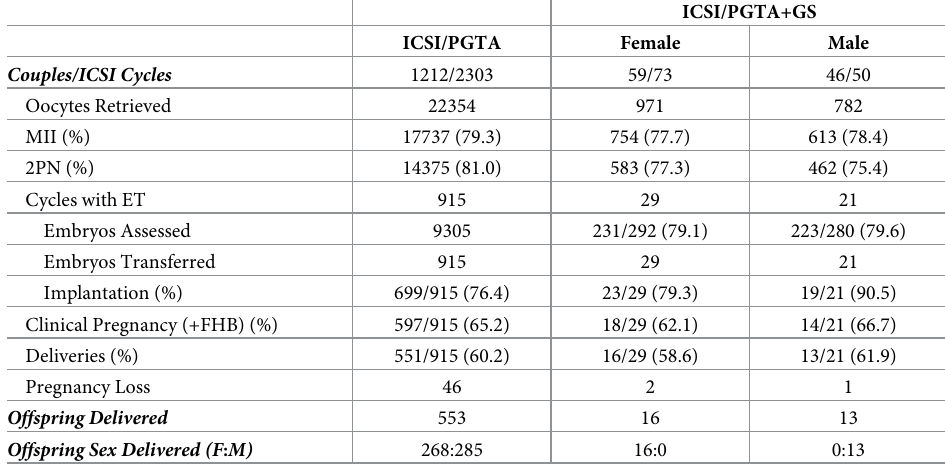
Table 3. ICSI outcomes by sex preference.